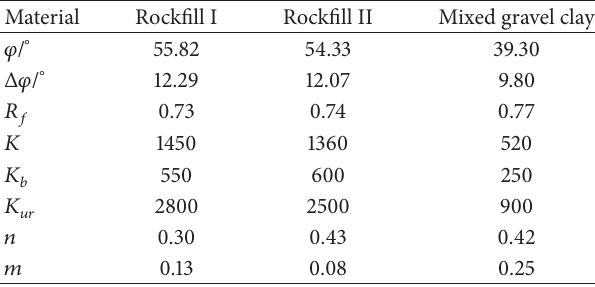
Table 1: Material parameters of Duncan and Chang’s EB